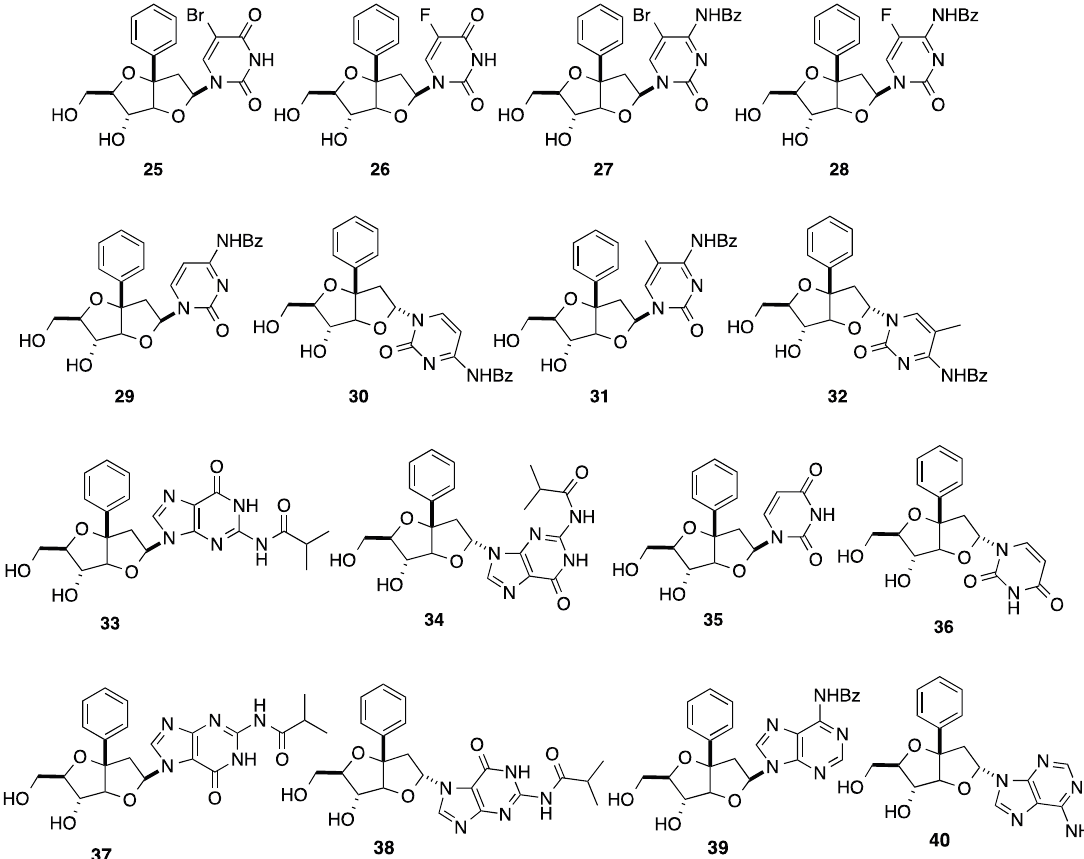
Figure 1. Bicyclo[3.3.0]octane nucleoside analogues 25 – 40 having a phenyl group [13–15].